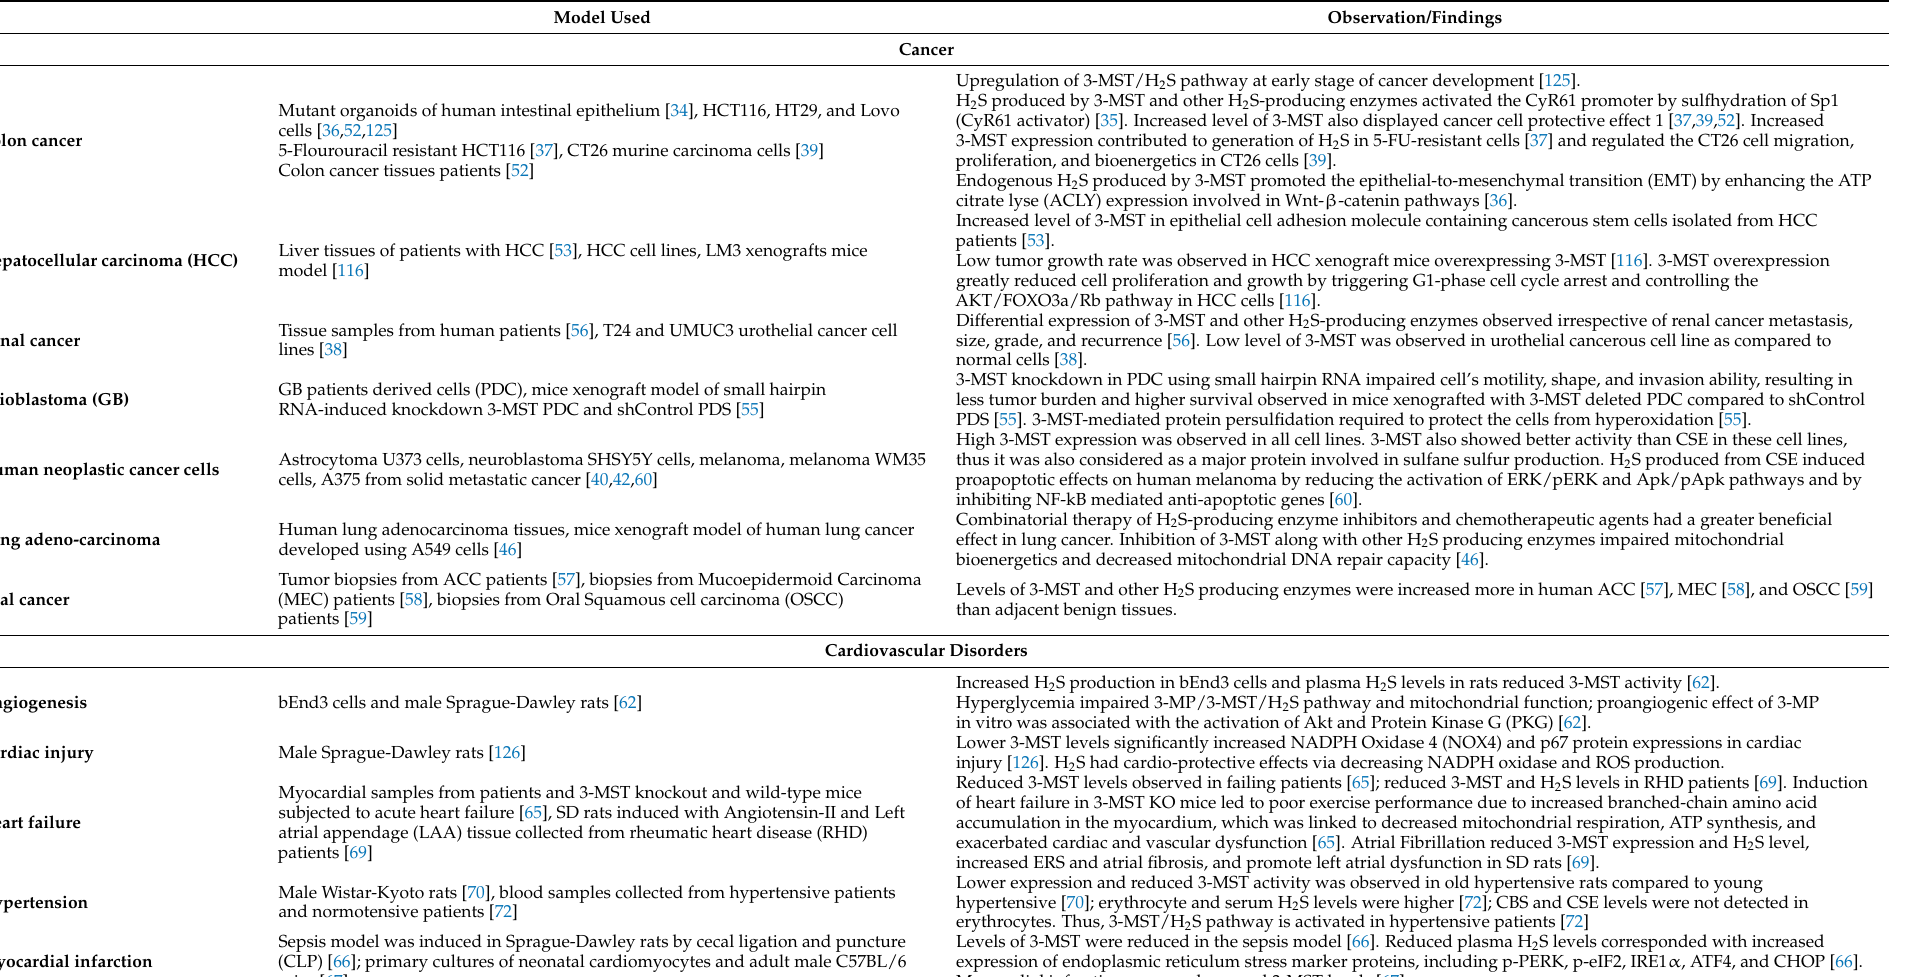
Table 1. Studies related to 3-MST mediated H 2 S release in disease